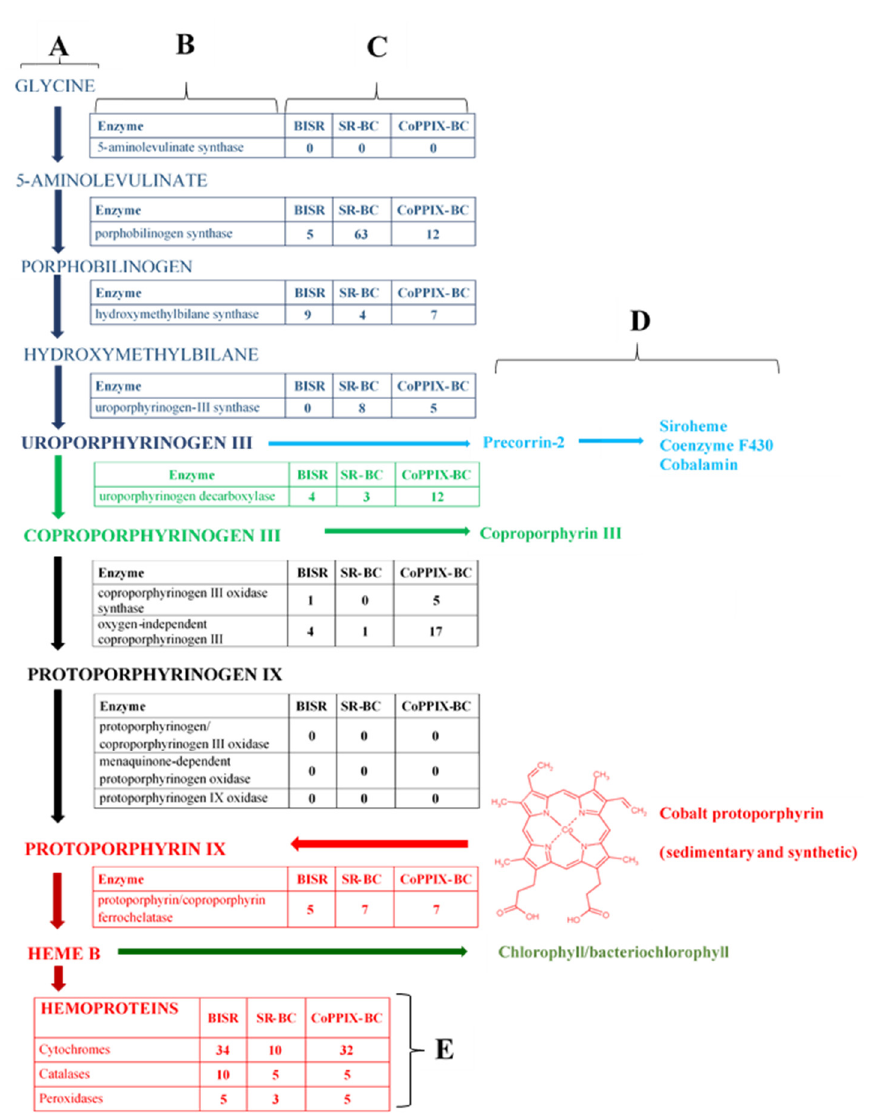
Figure 1. Biosynthesis of heme b including products ( A ) and enzymes ( B ); number of sequences of enzymes involved in heme b biosynthesis detected in metaproteome of BISR (bacteria inhabited shale rock) and proteomes of SR-BC (shale rock-bacterial culture) and CoPPIX-BC (cobalt protoporphyrin-bacterial culture) ( C ); biotransformation of uroporphyrinogen III, coproporphyrinogen and heme b not studied in this study ( D ). Number of sequences of hemoproteins (cytochromes, peroxidases, and catalases) detected in the studied metaproteome of BISRand proteomes of SR-BC and CoPPIX-BC ( E ). The figure does not take into account the transformation of heme b into other types of heme. Numbers of sequences of detected enzymes are presented in Tables S4 and S5. The PPIX transformations studied in this study are marked in red.